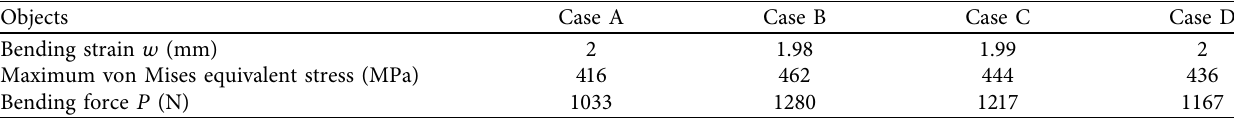
Table 11: Results of computer simulation of the elastoplastic deformation in the plates (with 2 mm deflection).